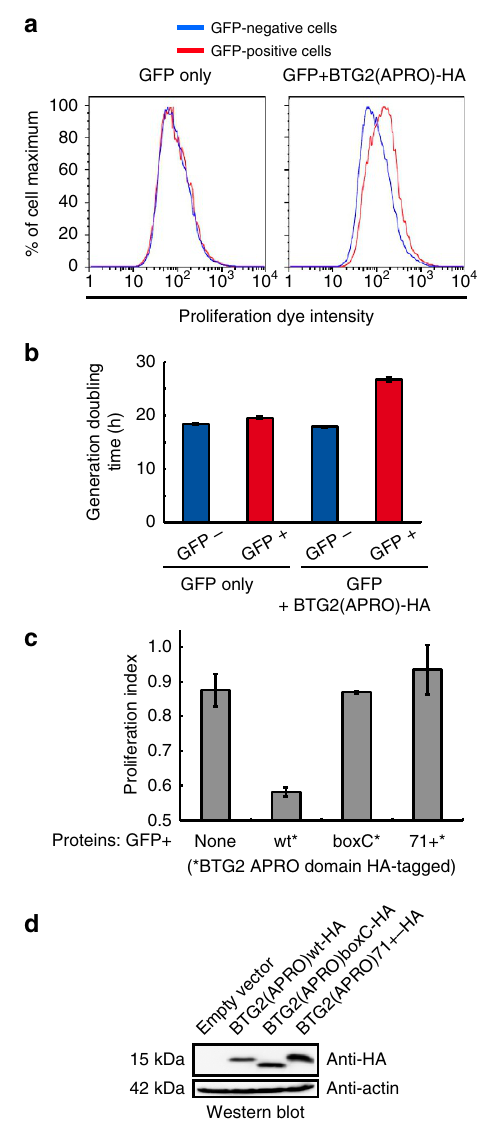
Figure 5 | Interaction between BTG2 APRO and PABPC1 RRMs is necessary for BTG2 APRO domain to reduce cell proliferation. ( a ) Histograms showing the cell proliferation dye intensities in cells expressing or not BTG2(APRO). U2OS cells were labelled with the cell proliferation dye eFluor 670 before seeding in transfection plates. One day later, the cells were co-transfected with plasmids expressing GFP and BTG2(APRO)-HA (right panel) or GFP and empty expression vector (left panel), and were analysed 3 days after transfection using flow cytometry. ( b ) Histogram representing generation time of cells expressing or not the APRO domain of BTG2. U2OS cells were treated as in a and analysed 48, 72 and 96h after transfection using flow cytometry. Half-life for the dilution of the mean proliferation dye intensity for the different cell populations was calculated from kinetic curves. These half-lives correlate directly to the cell-generation doubling time. Error bars (s.d.) correspond to two biological replicates. ( c ) Analysis of the ability of mutated BTG2 APRO domains to reduce cell proliferation. The analysis depicted in a was repeated with plasmids expressing WT, boxC-mutated (same mutation as in Fig. 3a) or 71 þ insertion-mutant BTG2 APRO domains, or empty expression plasmid as control. Proliferation rate changes, quantified from the eFluor670 dye dilution, are plotted according to the formula: Proliferation index ¼ 1 (cid:2) [(mean dye intensity for GFP-positive cells–average of mean dye intensities for GFP-negative cells from all samples)/average of the mean dye intensities for GFP-negative cells from all samples]. Hence, a value of 1 corresponds to the proliferation of fast-growing GFP-negative cells, while an index of 0 indicates a reduction of one cell cycle division after transfection. Average ( ± s.d.) from two biological replicates. ( d ) A western blot analysis of cell lysates corresponding to the experiment presented in c is shown to monitor expression of the BTG2 proteins. NATURE COMMUNICATIONS|7:10811|DOI: